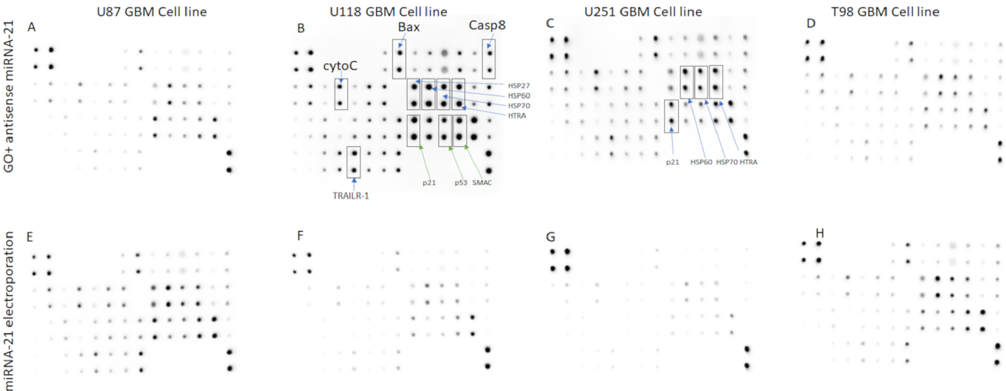
Figure 18. Antibody array analysis of proapoptopic protein synthesis in U87 ( A , E ), U118 ( B , F ), U251 ( C , G ) and T98 ( D , H ) glioma cells treated with complexes of graphene oxide functionalised with antisense miRNA-21 ( A – D ) and miRNA-21 by electroporation ( E – H ). GO + antisense miRNA-21 treatment results in the upregulation synthesis of Bcl-2-associated X protein (BAX), caspase-8, heat shock protein 27 (HSP27), heat shock protein 60 (HSP60), TNF-related apoptosis-inducing ligand (TRAILR-2), second mitochondria-derived activator of caspase (Smac) and cytochrome c in U118 ( B ) and U251 ( C